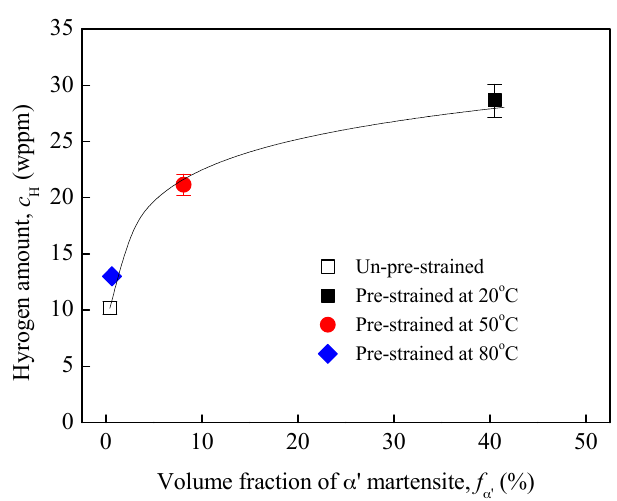
Figure 7. Total hydrogen amounts charged into the steel as a function of pre-existing α′ martensite.